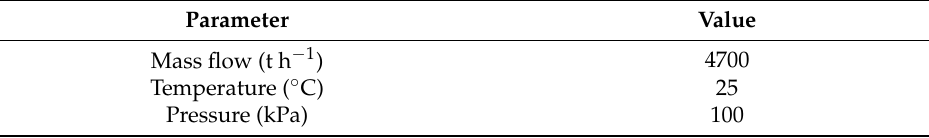
Table A2. Inlet cooling water parameters [29].